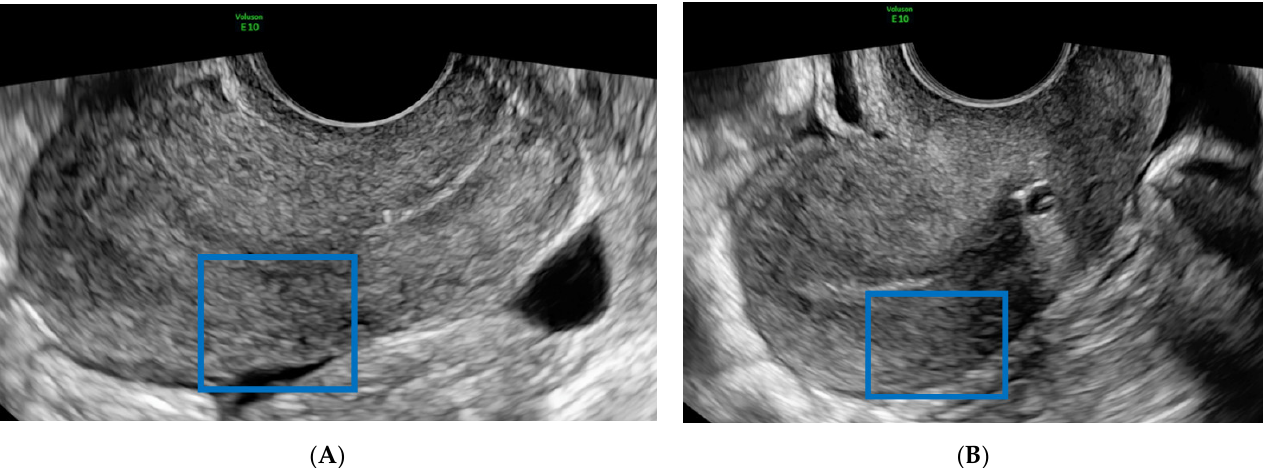
Figure 1. ( A ) Preoperative ultrasonography of the pelvis (the blue square denotes the area of interest). ( B ) Postoperative ultrasonography of the pelvis.